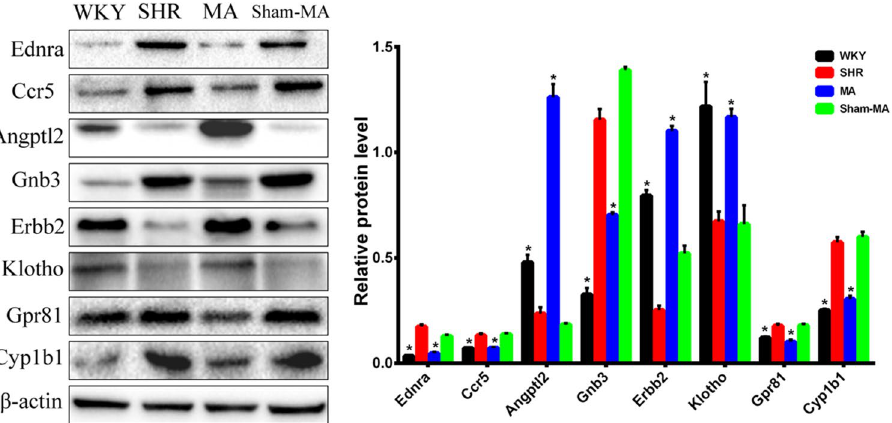
Figure 8. Validation of the up/downregulated genes using western blot. The loading control protein β-actin was used for normalization. Data are expressed as the mean ± SD. *p < 0.05 versus the SHR group (F (Ednra) = 483.27, F (Ccr5) = 82.53, F (Angptl2) = 254.11, F (Gnb3) = 236.63, F (Erbb2) = 507.16, F (Klotho) = 655.65, F (Gpr81) = 60.18, F (Cyp1b1) = 43.76, one